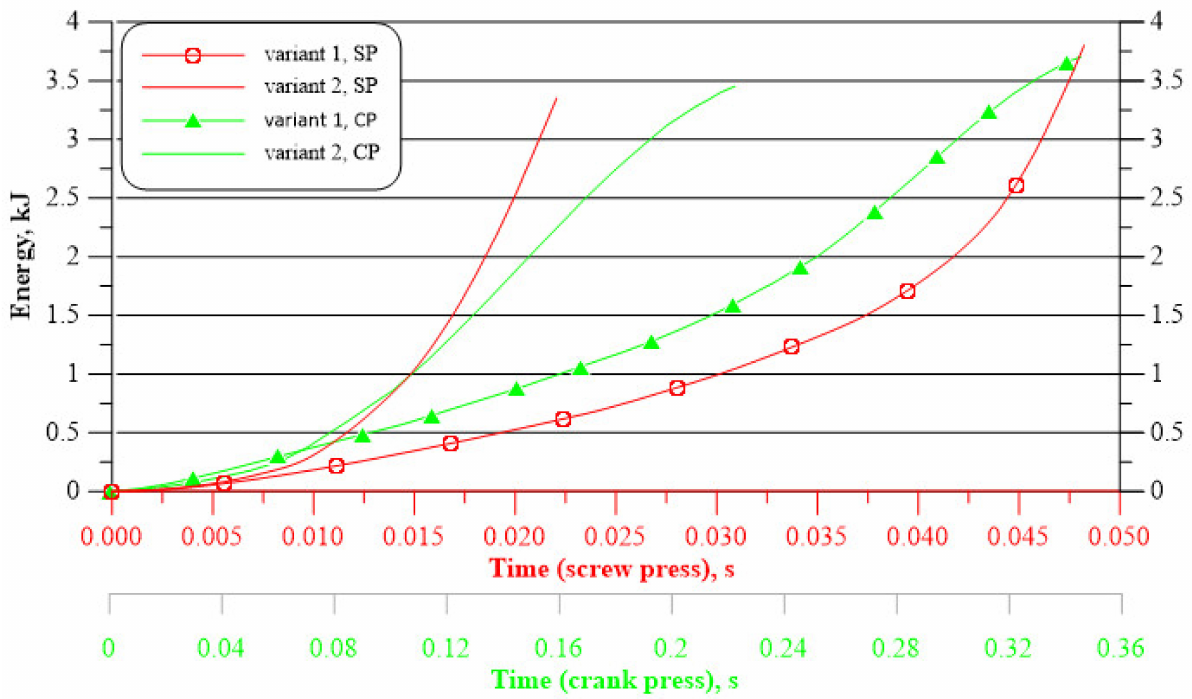
Figure 22. Impact energy of the upper die as a function of time for forging a connecting rod forging from preforms made of 71100